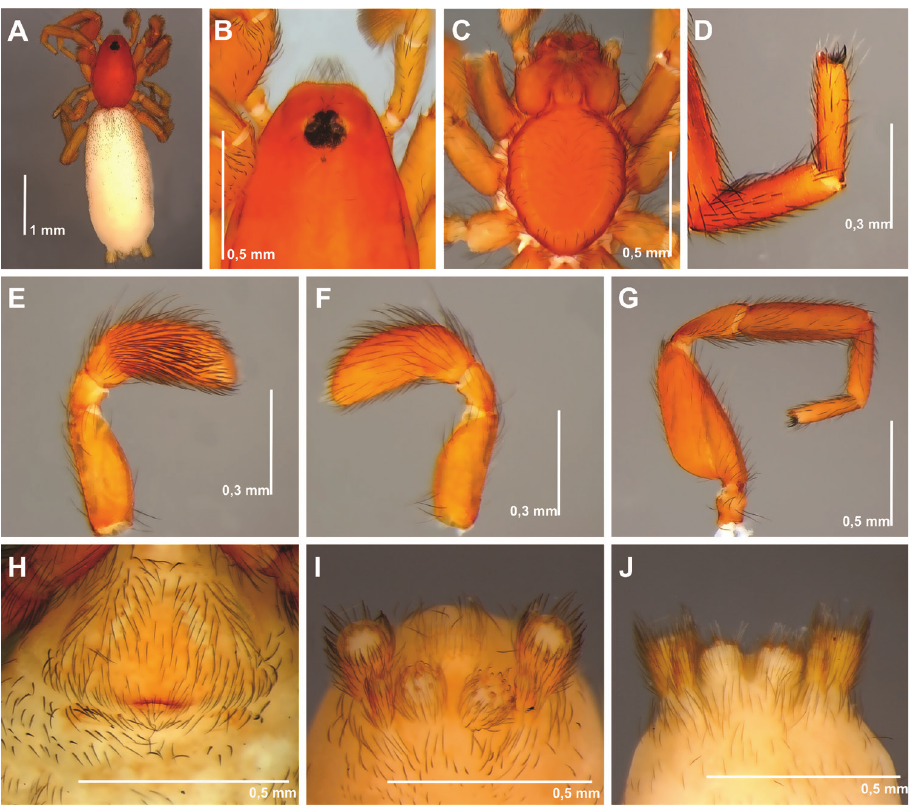
Figure 6. Taintnops paposo sp. n. from Taltal, Antofagasta, Chile, female paratype ( A–J ) A habitus, dor- sal view B carapace, ocular area, dorsal view C carapace, ventral view D leg I, metatarsus and tarsus distal, retrolateral view E pedipalp , prolateral view F same, retrolateral view G leg I, prolateral view H genital area, ventral view I spinnerets , posterior view J same, ventral